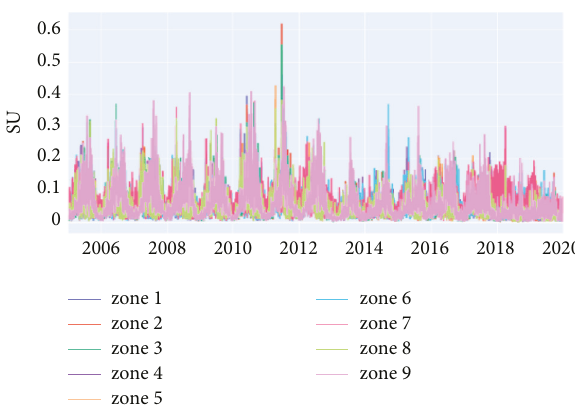
Figure 2: Temporal variability of monthly mean of aerosols over studied